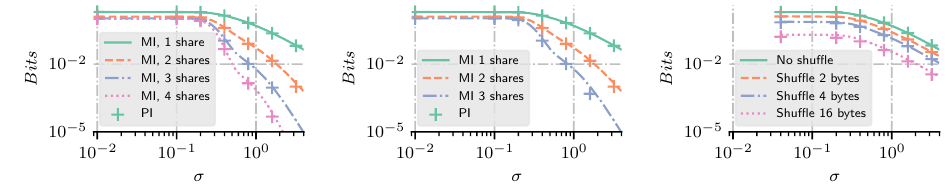
Figure 1: Information perceived by the MLP in Experiments 1 (top left), 2 (top right) and 3